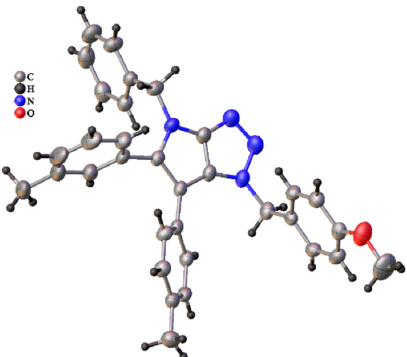
Figure 2. View of the asymmetric unit of 41 at 293 K with thermal ellipsoids drawn at the 30% probability level. The disordered phenyl ring on position 6 is represented with only one position for clarity (methyl moieties below the central ring).